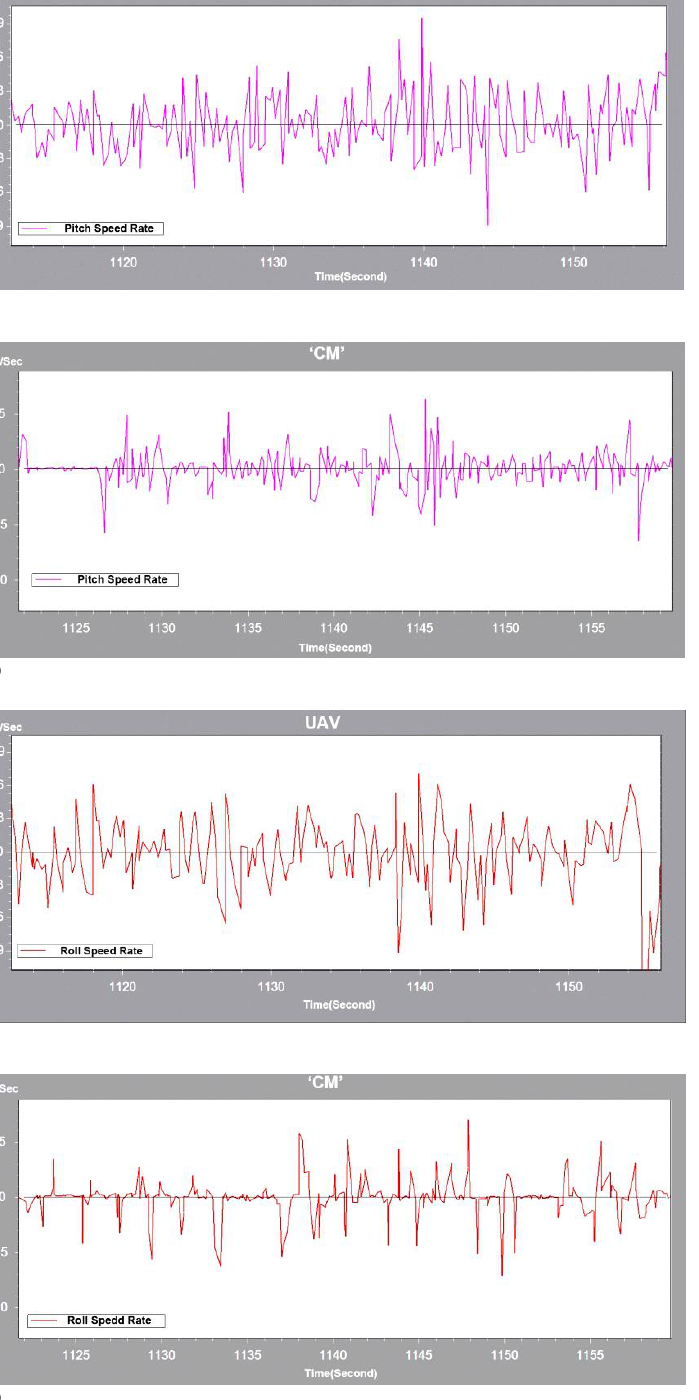
Figure 3. shows the angular velocity in rad/s at the same time period for : (a) the pitch rate of the UAV, (b) pitch rate of the CM , (c) roll rate of the UAV, (d) roll rate of the